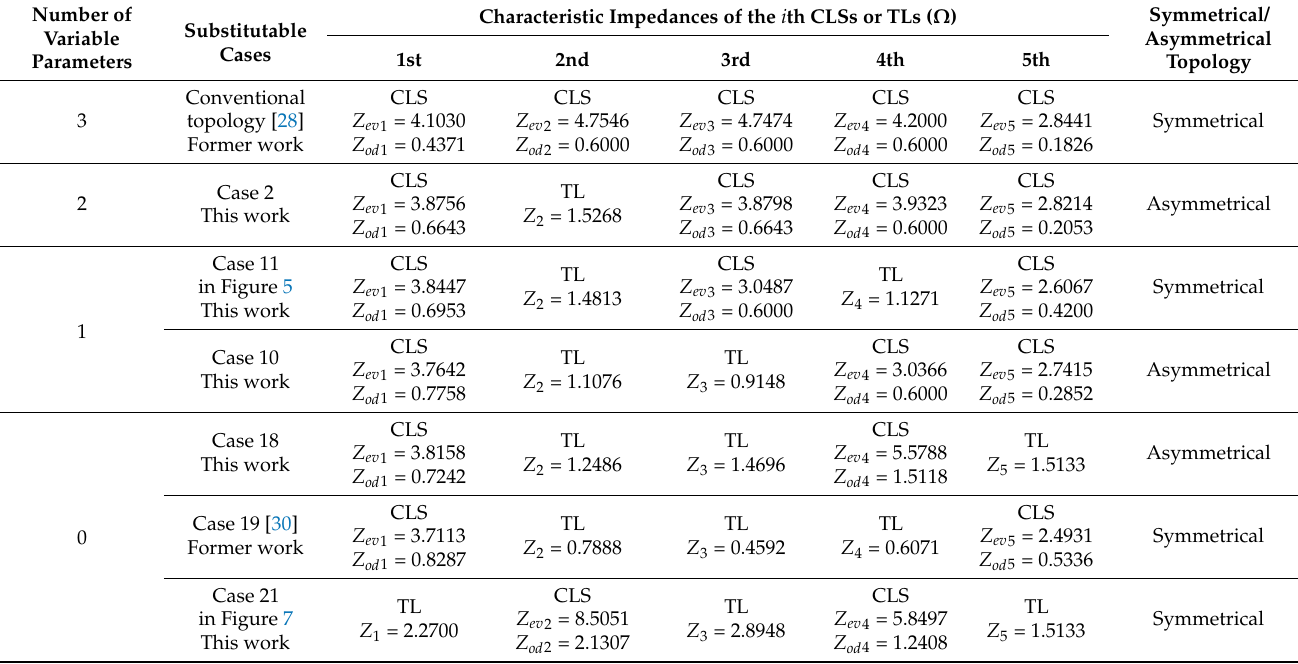
Table 5. Typical simplification examples with detailed parameters, under the condition of Z S = 1.5 Ω